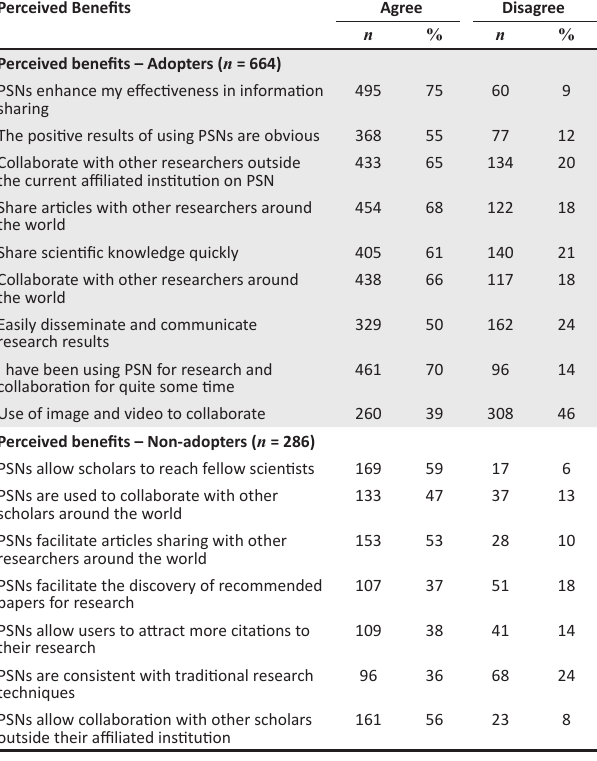
FIGURE 2: Diffusion of professional social networks at South African universities. TABLE 2: Perceived benefits of professional social